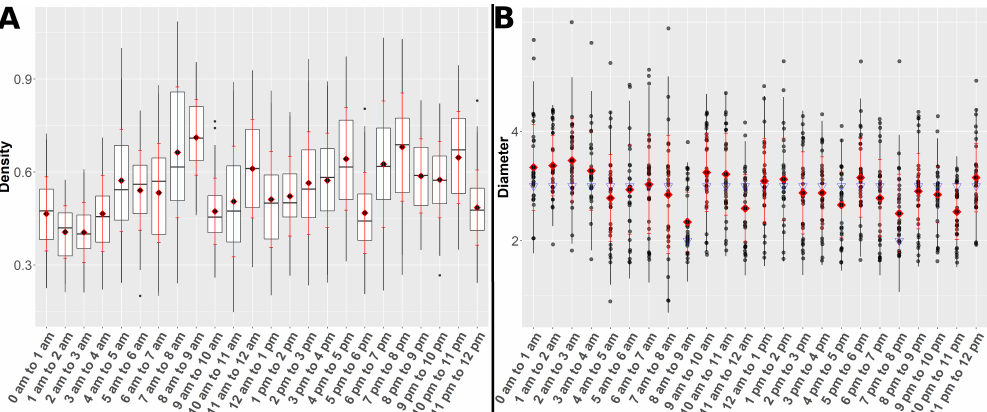
Figure 6. The underlying hourly contact networks were obtained between 2nd of June and 3rd of July 2018. ( A ) Boxplot of the density values. The red diamonds mark the means and the red bars represent the mean ± standard deviation. ( B ) Pointplot of the diameter values. The red diamonds mark the means and the red bars represent the mean ± standard deviation. The blue triangles mark the medians. In order to avoid overplotting of points as the diameter only takes integer values between one and six in this analysis, 1.5% position jitter was